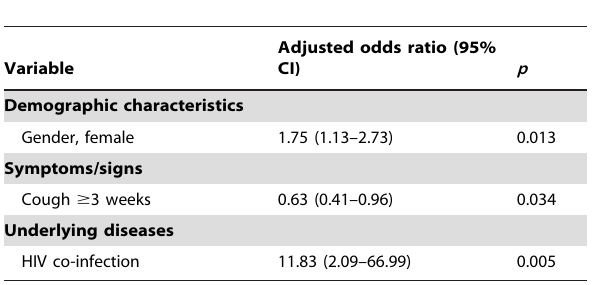
Figure S1 Flow chart of selection of patients with PTB from NHIRD. (TIF)